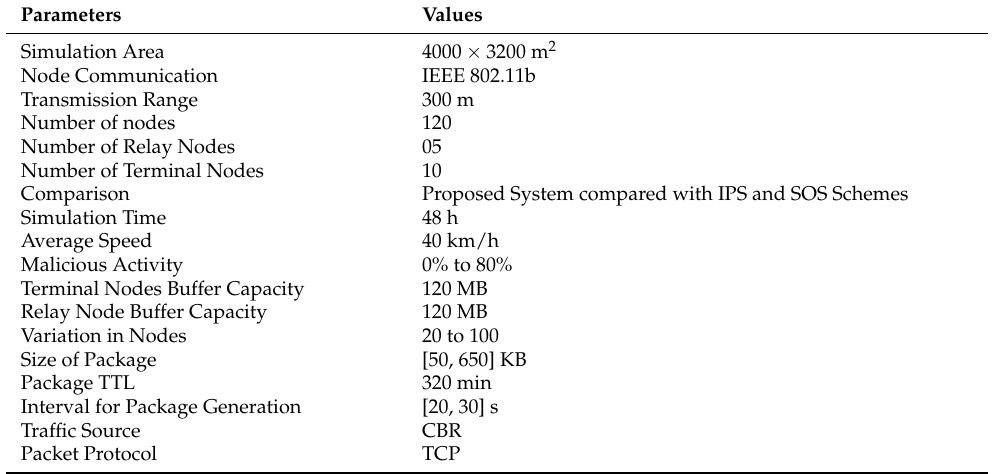
Table 5. Simulation